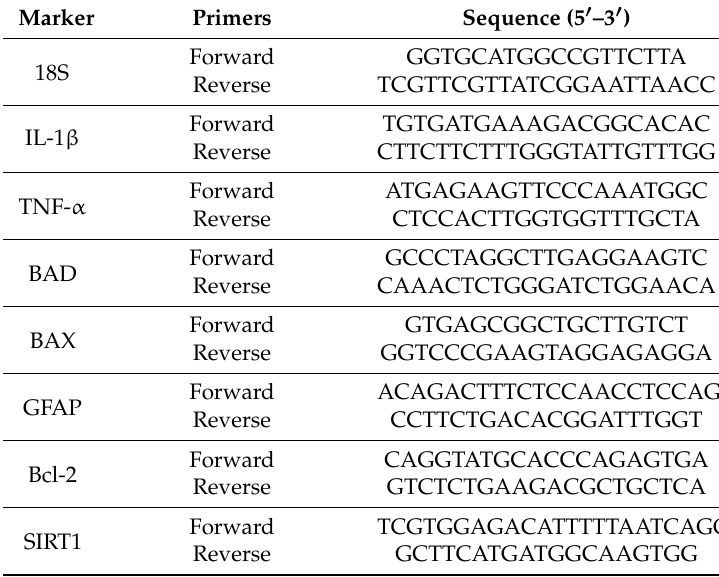
Table 1. Primers used in RT-PCR experiments. 18S was used as a housekeeping gene to compare the samples. Marker Primers Sequence (5 (cid:48) –3 (cid:48)